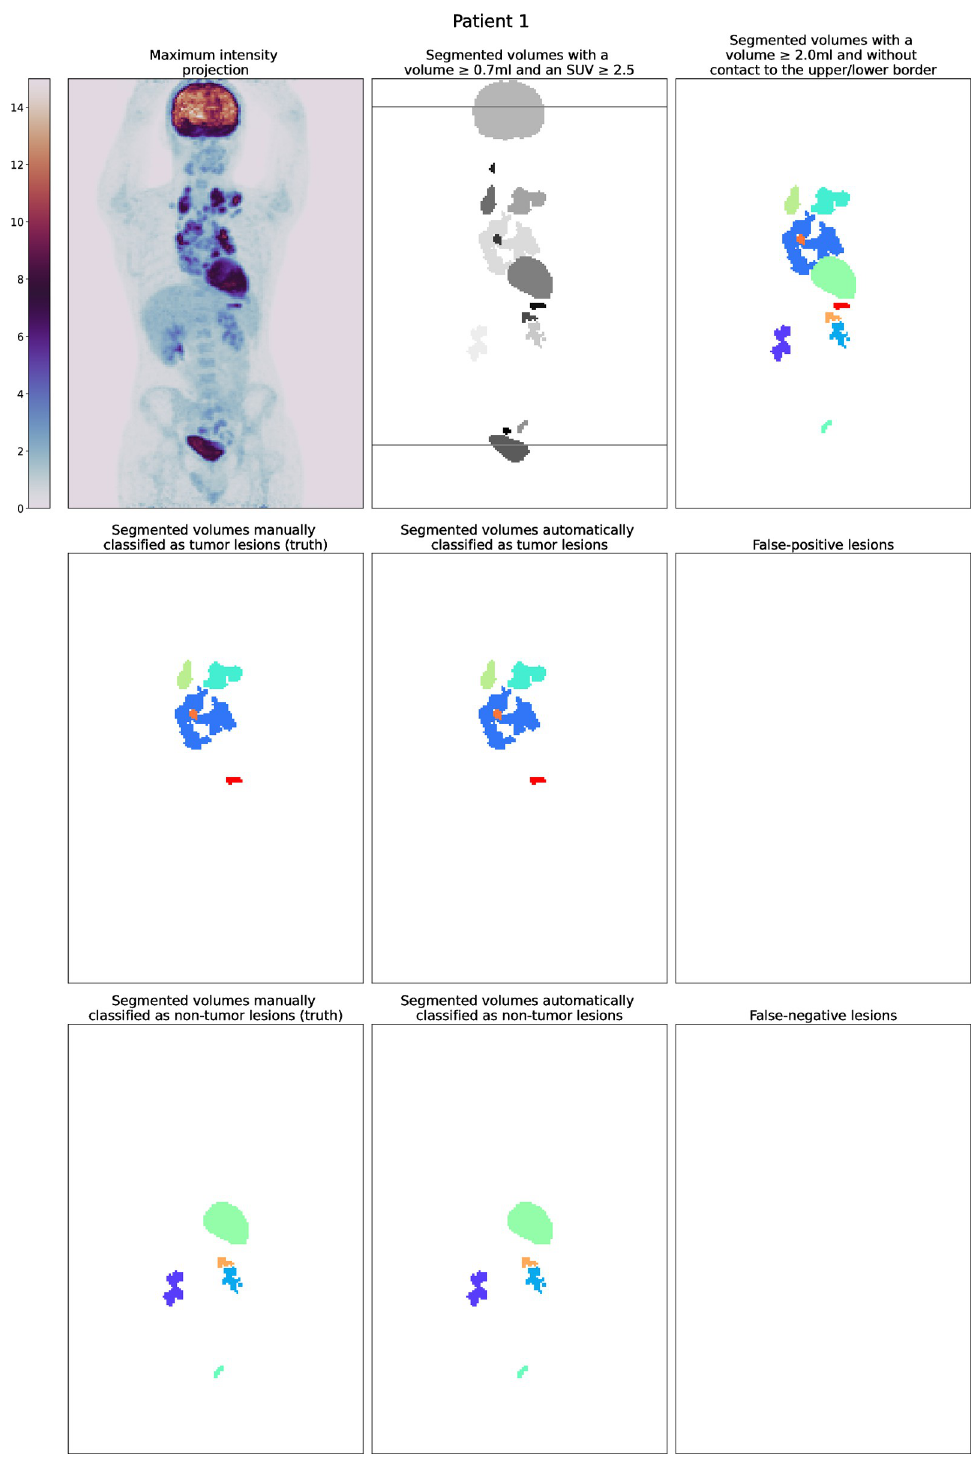
Fig 2. Patient from the EuroNet-PHL-C1 study with an optimal automatic classification.